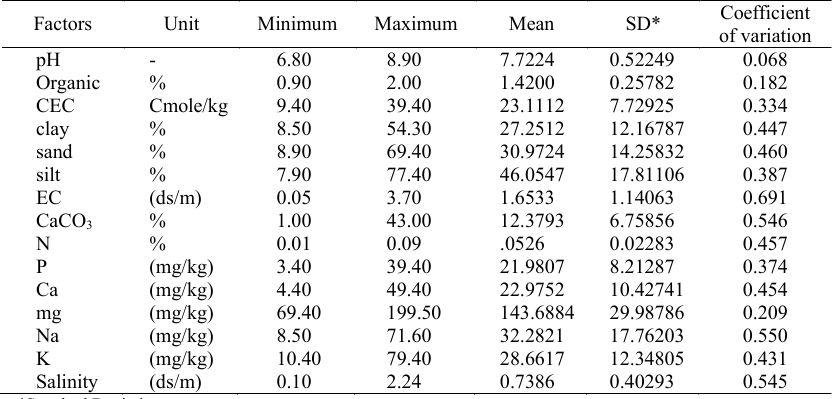
Table 2: Physio-chemical characteristics of the soils used in the study